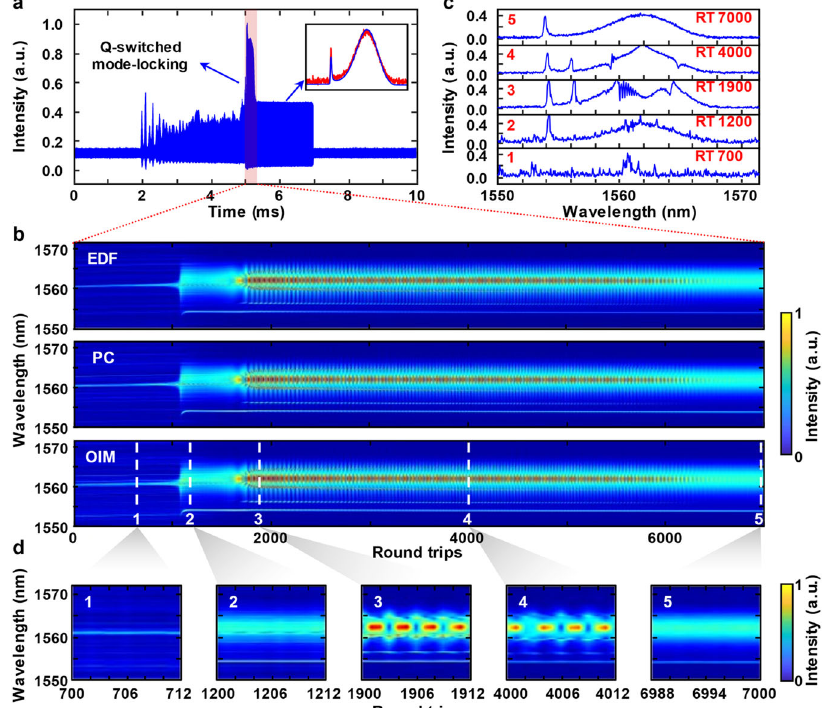
Fig. 3 Soliton formation process. a Spectral information captured by the DFT method. b The real-time evolution process of the soliton establishment, including 5 different physical processes. The output of the three ports is different in detail. EDF erbium-doped fi ber, PC polarization controller, OIM optical integrated module. c Typical cross-sections of the spectra. The drift of the Kelly sideband can be observed owing to the accurate spectral trigger. d Zoom in spectral evolution of 5